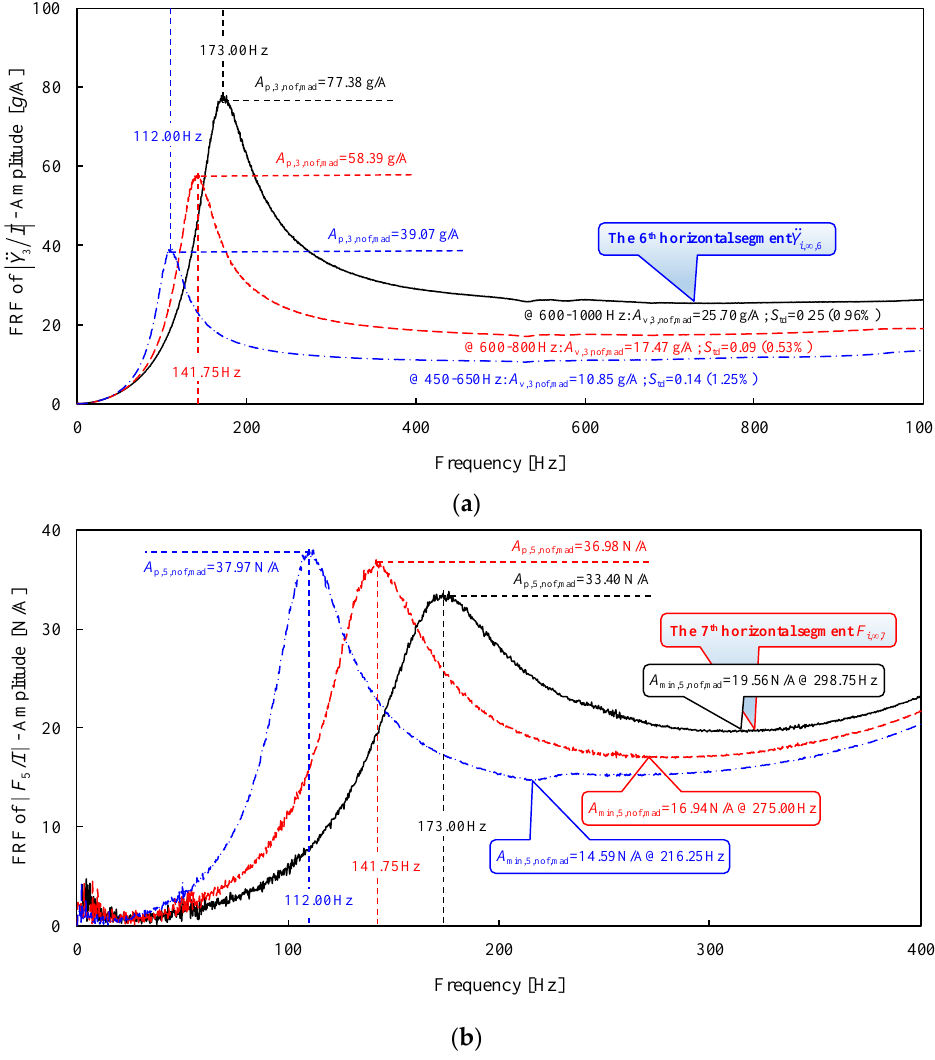
(cid:12) (cid:12) .. (cid:12) (cid:12) Y I (0–1000 Y 3 / I (cid:12) (cid:12) (0–1000 Hz), 3